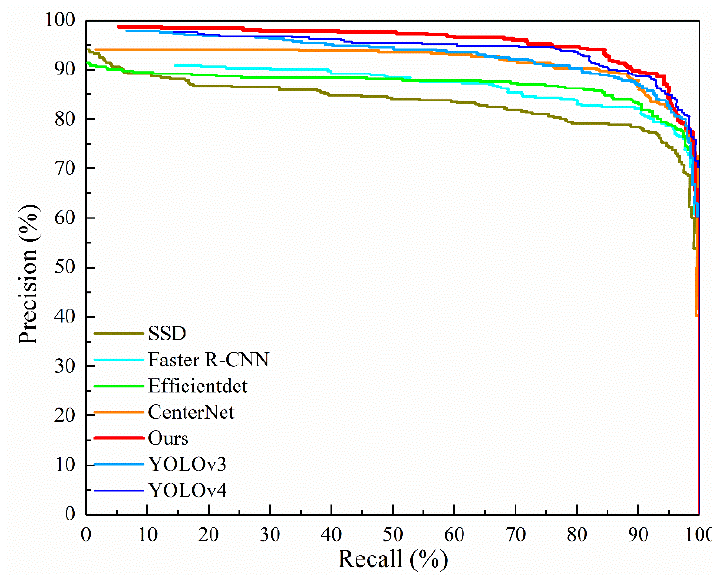
Figure 7. PR curves for the seven detection models. Table 1. Detection results with different object detection networks.